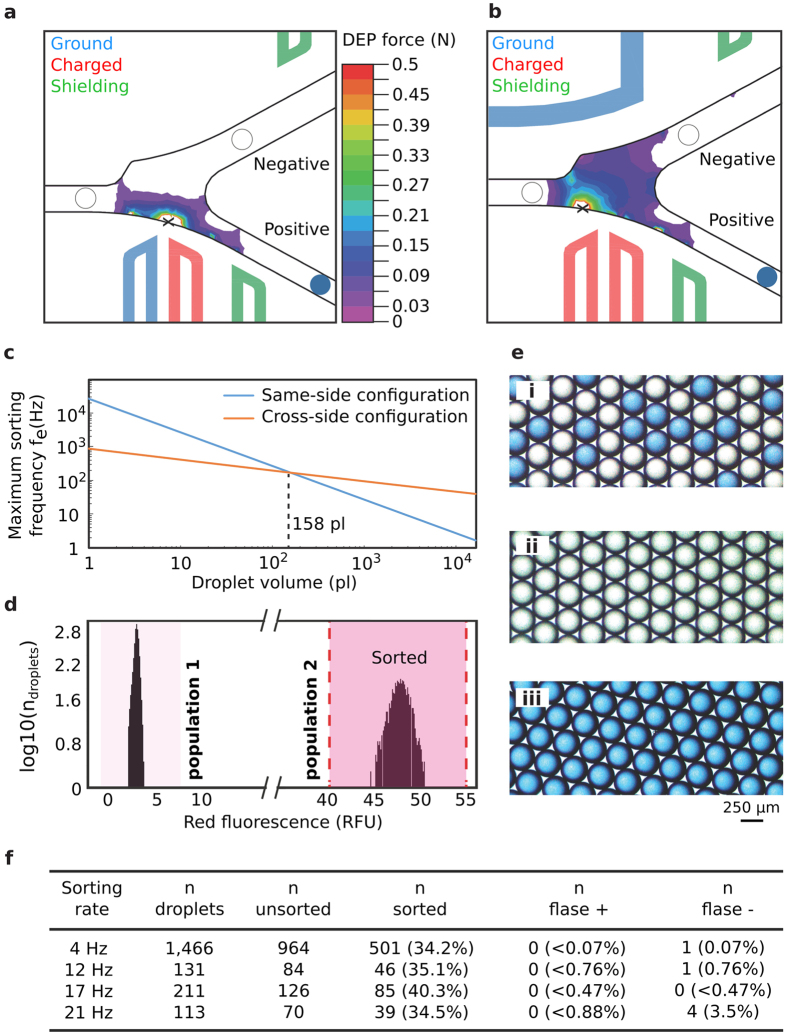
Validation of the sorting device.(a) Same-side electrode configuration: schematic and DEP force simulation (b) Cross-side electrode configuration: schematic and DEP force simulation. The corresponding electrical potential distributions for each electrode configuration are shown in Figure S2. (c) Calculated maximum sorting frequency fe as a function of droplet volume for same-side and cross-side configurations. (d) Fluorescence histogram of a binary emulsion of 10 nl droplets containing 1 μM sulforhodamine B (population 1, 65%) or 30 μM sulforhodamine B plus blue ink (population 2, 35%) before sorting using the DEP sorter with the cross-side electrode configuration. The sorting gate was set to sort only droplets with red fluorescence between 40 and 55 RFU (vertical dashed lines) corresponding to population 2. (e) Color pictures of the emulsion before (i) and after sorting at 4 droplet.s−1 from the negative (ii) or positive (iii) channels. (f) Video analysis of the sorting efficiency at different throughputs.